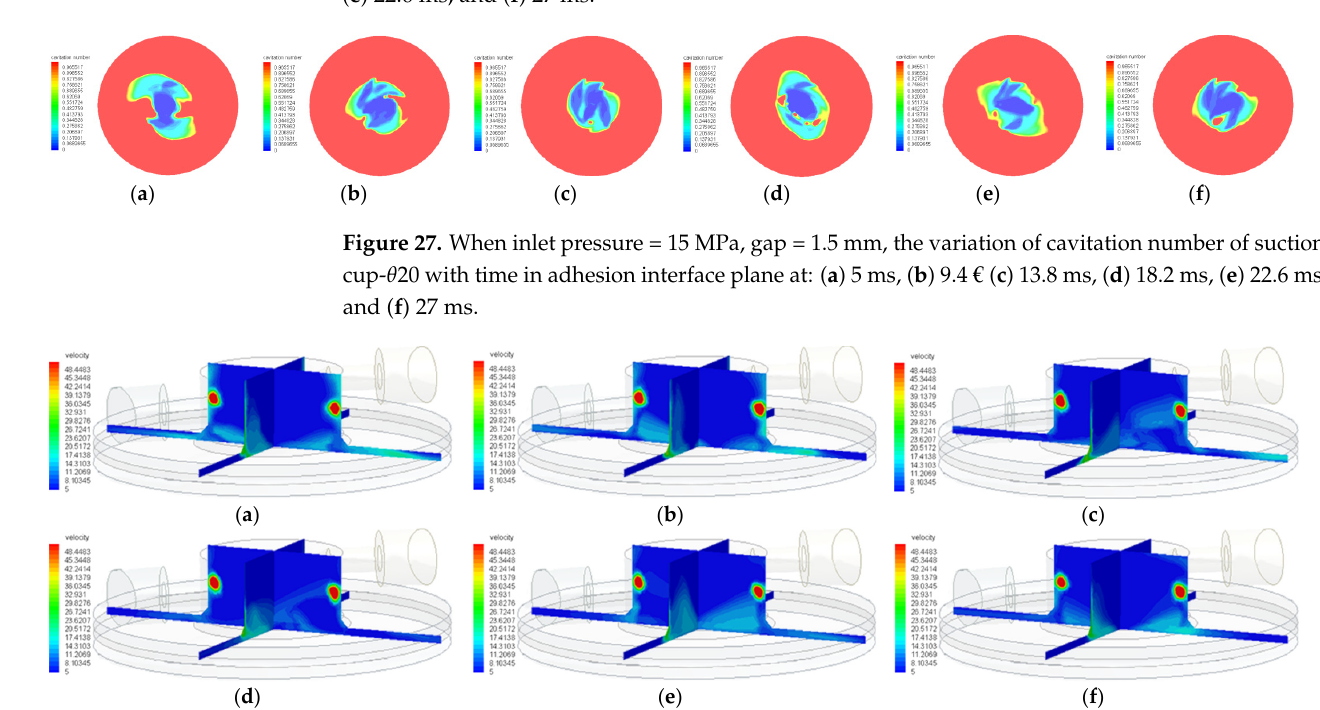
Figure 26. When inlet pressure = 15 MPa, gap = 1.5 mm, the variation of cavitation number of suction cup- θ 20 with time in vertical axial cross planes at: ( a ) 5 ms, ( b ) 9.4 ms, ( c ) 13.8 ms, ( d ) 18.2 ms, ( e ) 22.6 ms, and ( f ) 27 ms.